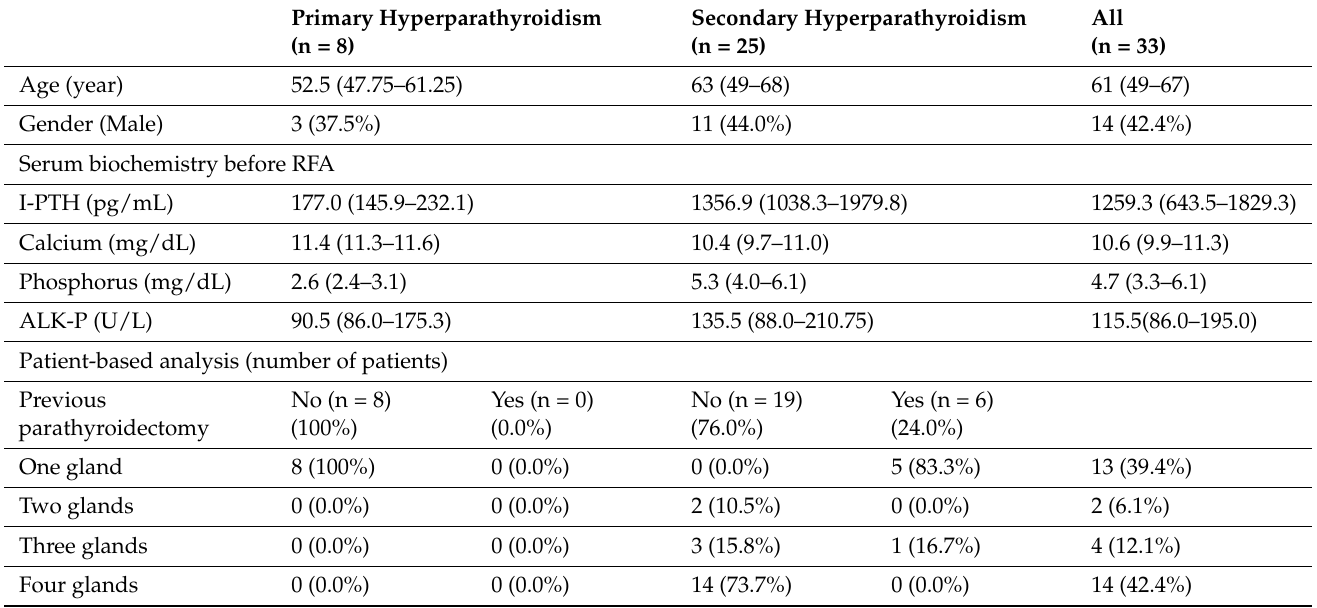
Table 1. Demographic and Clinical Characteristics of Patients.